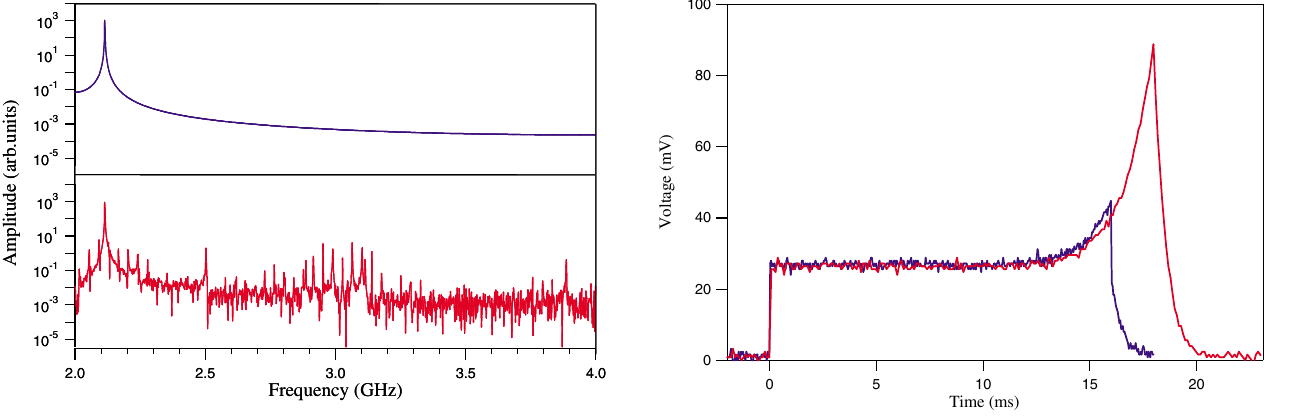
FIG. 5. (Color) HOM voltage measured from the unstable cavity for 16 ms (blue) and 18 ms (red) long macropulses with an average current of 3.5 mA.